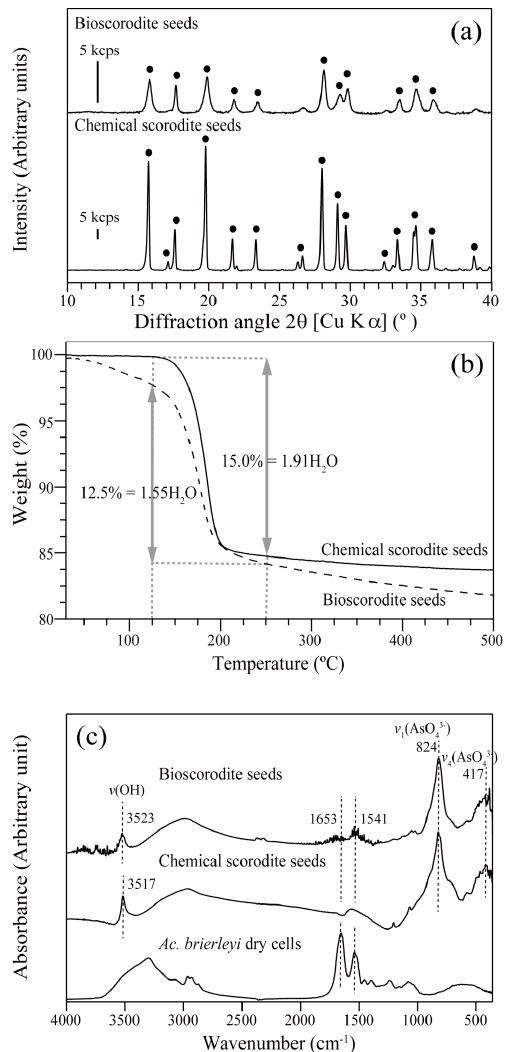
Figure 1. Characterization of bioscorodite and chemical scorodite by XRD ( a ), TG-DTA ( b ) and FT-IR ( c ) analyses. ( a ) The symbol ● is assigned to scorodite (JCPDS 37-0468). ( b ) The structural water content was calculated based on the weight loss at 125–250 °C of bioscorodite (broken line) and chemical scorodite (solid line). ( c ) Dotted lines at 417 and 824 cm − 1 can be assigned to AsO 43 − stretching vibration (436 and 825 cm − 1 ) [21] and those at 3523 and 3517 cm − 1 to OH stretching vibration (3511 cm − 1 ) [22]. Two peaks at 1541 and 1653 cm − 1 are attributed to cell proteins (1545 and 1654 cm − 1 ) [23].